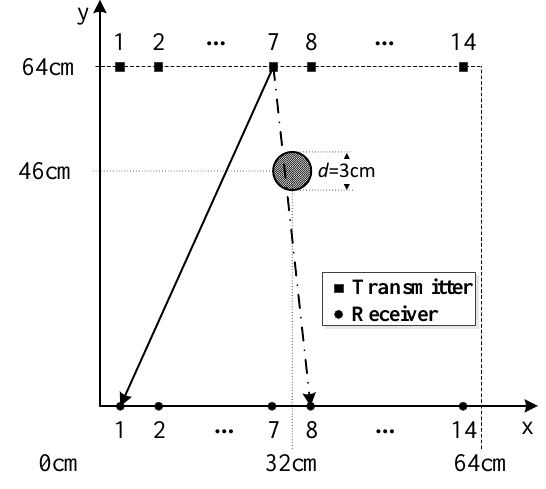
Figure 10. Schematic diagram of the ULW TI area.